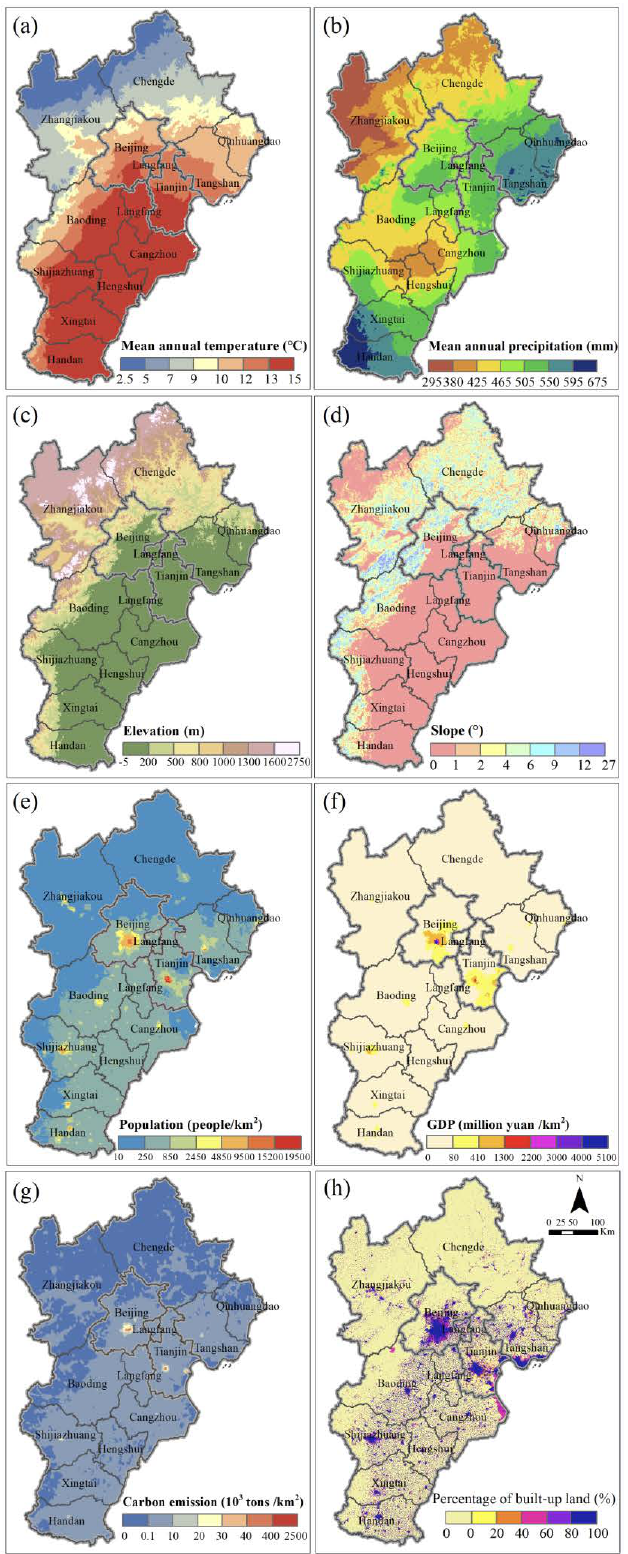
Figure 3. Spatial pattern of resilience impact factors. ( a ) temperature; ( b ) precipitation; ( c ) elevation; ( d ) slope; ( e ) population; ( f ) GDP; ( g ) carbon emission; ( h ) built-up